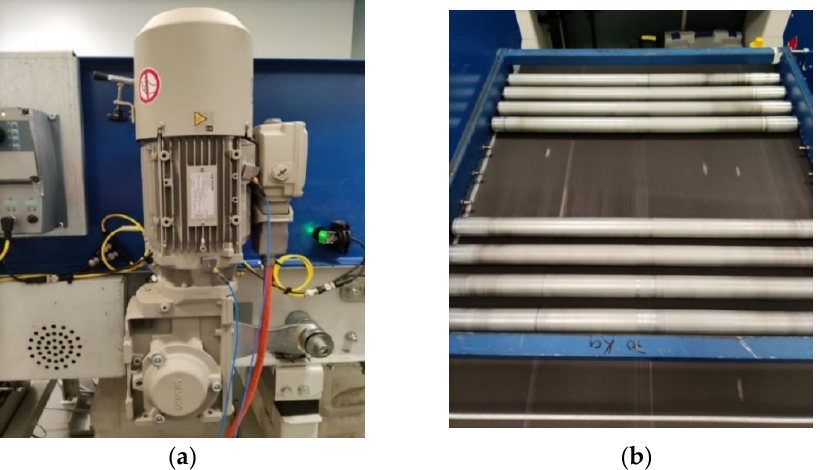
Figure 1. The experimental setup: ( a ) the gearmotor of the conveyor belt system; and ( b ) the loaded conveyor belt system.